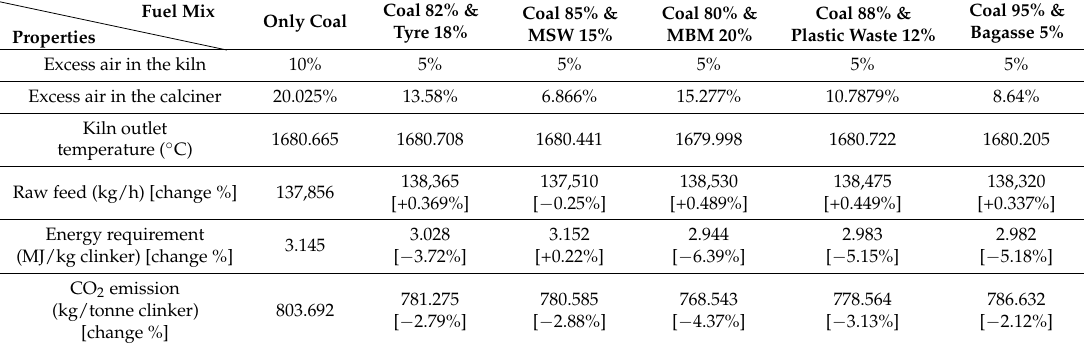
Table 7. Analysis of potential improvement in emission and energy